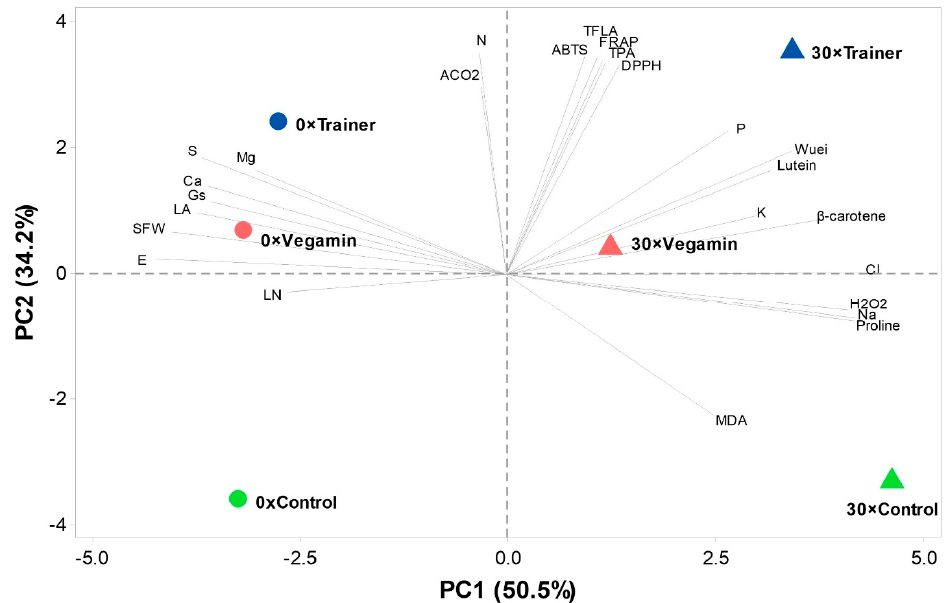
Figure 1. Principal component loading plot and scores of the principal component analysis (PCA) on biometric (leaf number (LN), leaf area (LA), shoot fresh weight (SFW)) physiological and biochemical (carbon dioxide accumulation (A CO2 ), stomatal conductance (g s ), transpiration (E), proline, MDA and H 2 O 2 ), mineral content (N, P, K, S, Ca, Mg, Na, Cl), auxiliary pigments ( β -carotene and lutein), antioxidant activity (DPPH, ABTS, FRAP), total phenolic acids (TPA) and flavonoid contents (TFLA) of lettuce plants as modulated by salt (0, 30 mM) and biostimulant (“Trainer”, “Vegamin”) applications.